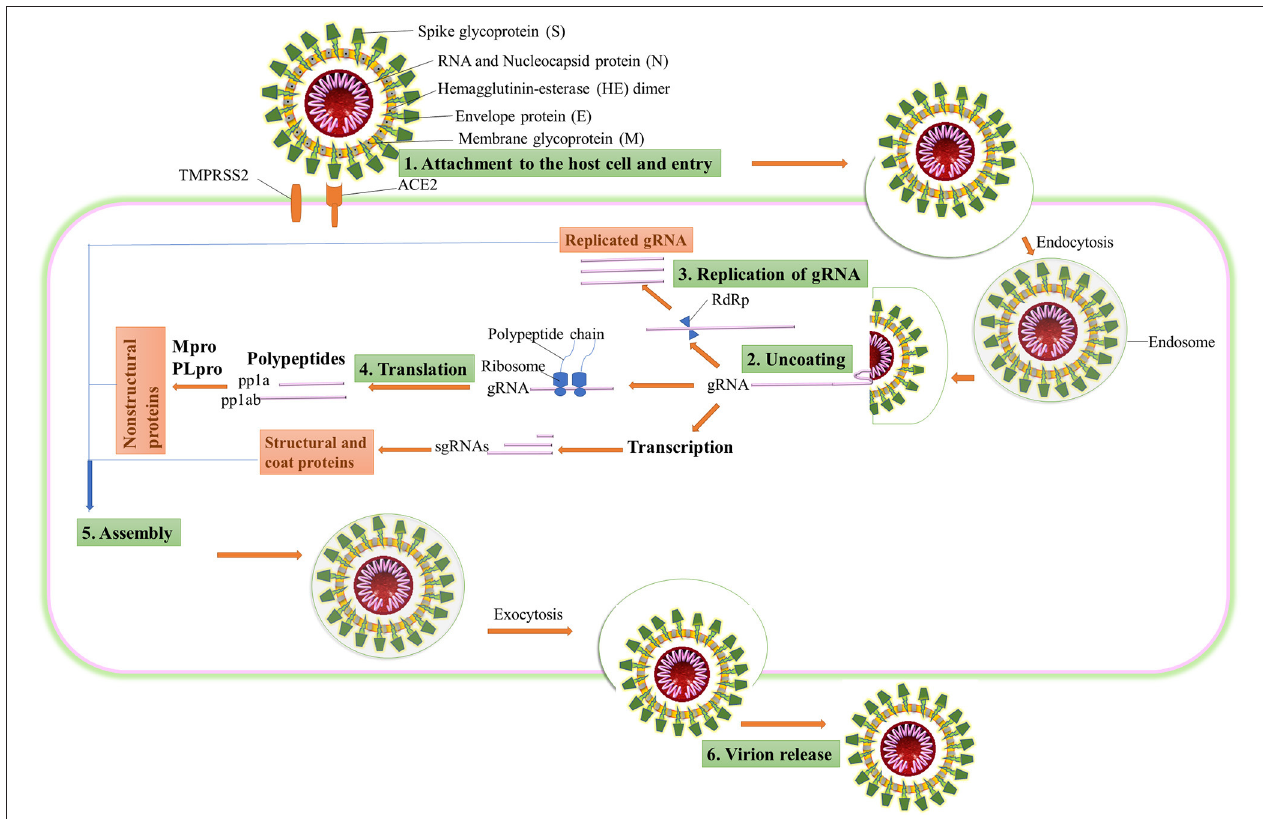
FIGURE 1 | The life cycle of SARS-CoV-2 in the host cell. ACE2, angiotensin-converting enzyme 2; TMPRSS2, type 2 transmembrane serine protease; gRNA, genomic RNA; RdRP, RNA-dependent RNA polymerase; sgRNA, subgenomic RNA; pp1a, polyprotein 1a; pp1ab, polyprotein 1ab.